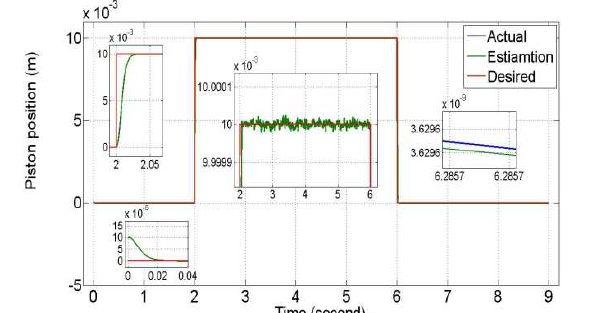
Fig. 14. Closed loop under parametric uncertainties with desired piecewise (cid:157) (cid:158) piston